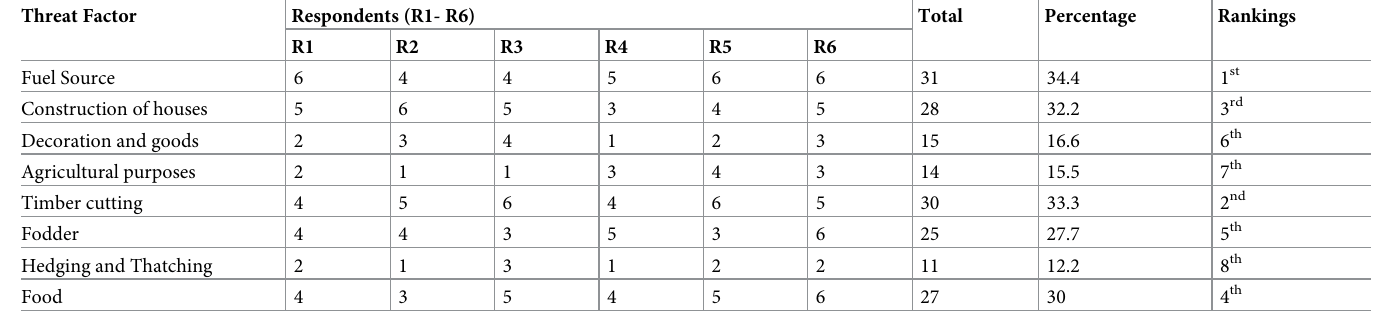
Table 8. Priority ranking (PR) index in the study area from Shiwalik Mountain Range of District of AJK, Pakistan (with destructive threat order: R6 < R5 < R4 < R3 < R2 < R1; 6 is the most destructive value). Threat Factor